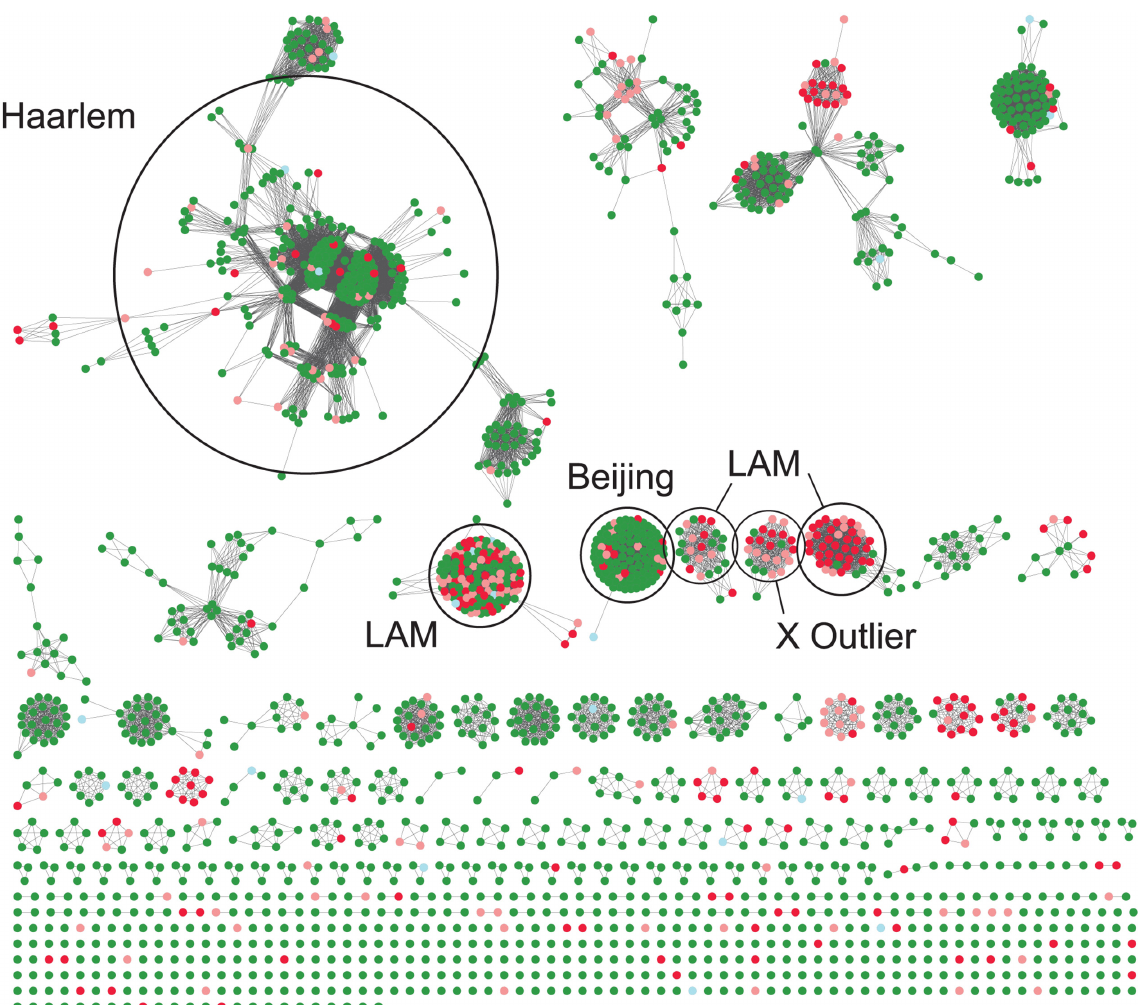
Fig 3. A minimum spanning tree of all study genotypes. Each coloured node is a different patient; green drug sensitive, red multidrug resistant, pink mono-resistant, light blue unknown. Patients grouped closely together have identical MIRU types and spoligotypes. A linking line between nodes denotes a change in Manhattan distance equal to